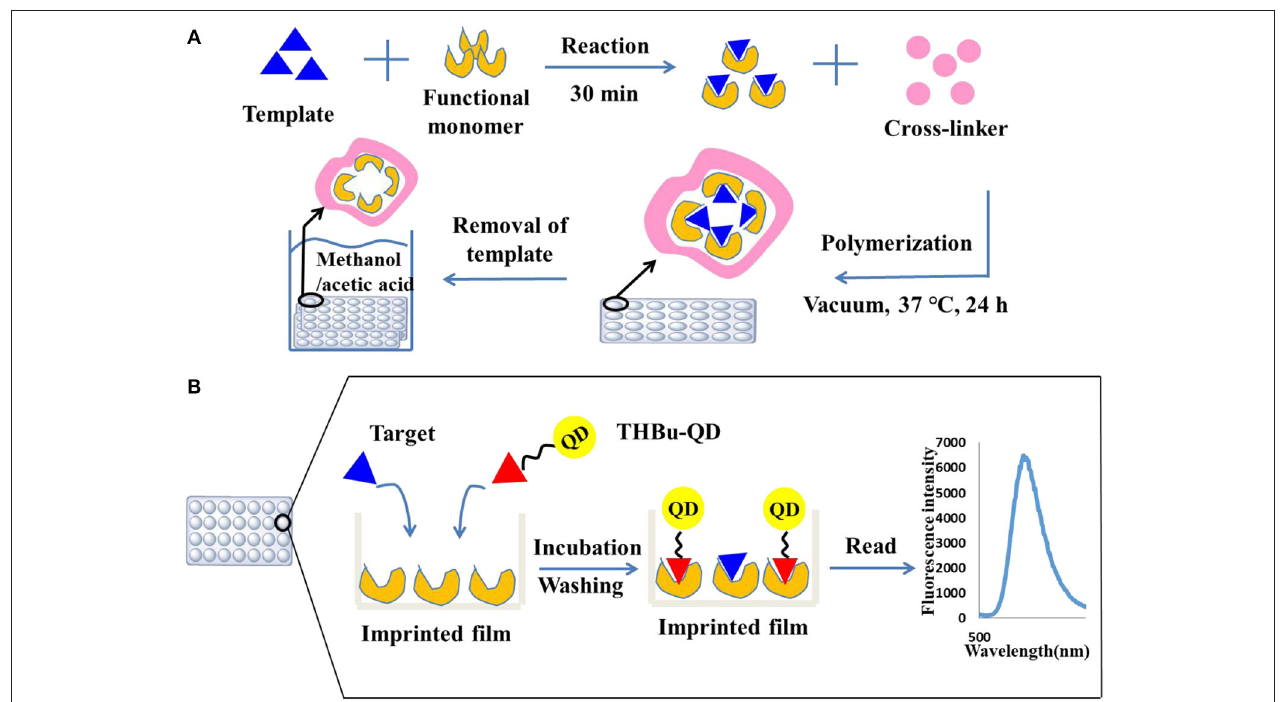
FIGURE 1 | Preparation of the molecularly imprinted film on the surface of the 96-well plate (A) and direct competitive BFIA (biomimetic fluorescence immune-sorbent assay) procedure (B) .